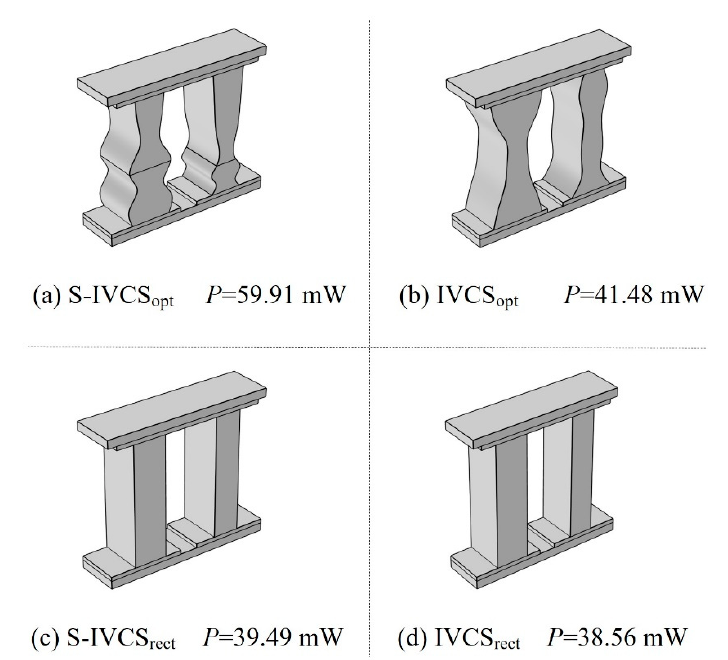
Energies 2022 , 15 , x FOR PEER REVIEW 14 of 20 Figure 9. The optimized designs compared with the conventional ones with the same volume. ( a ) S-IVCS; ( b ) IVCS; ( c ) rectangular counterpart of S-IVCS; ( d ) rectangular counterpart of IVCS.